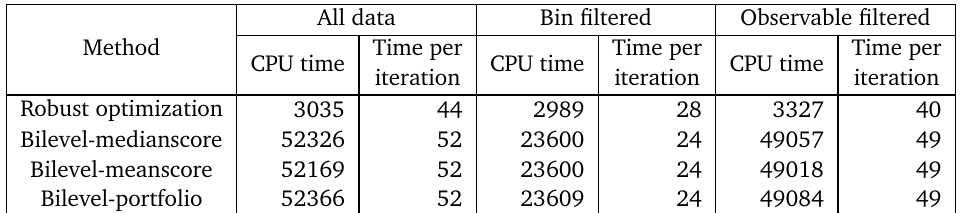
Table 12: CPU time (in seconds) and time per iteration (in seconds) taken by all approaches when using all, the observable-filtered, and the bin-filtered A14 data. The robust optimization approach converges after 69, 105, and 83 iterations,